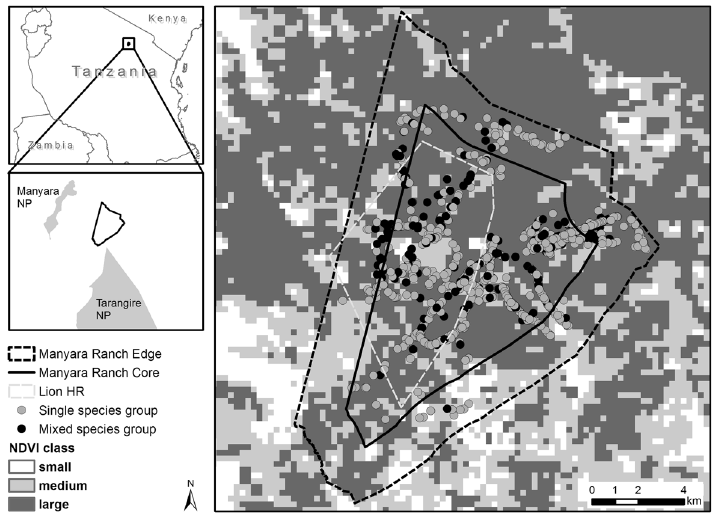
Figure 1. Location of single- and mixed-species groups of large mammal species, in relation to lion home range (85% minimum convex polygon) and vegetation productivity (mean NDVI from study period; darker shading corresponds with greater NDVI values) within Manyara Ranch, northern Tanzania.